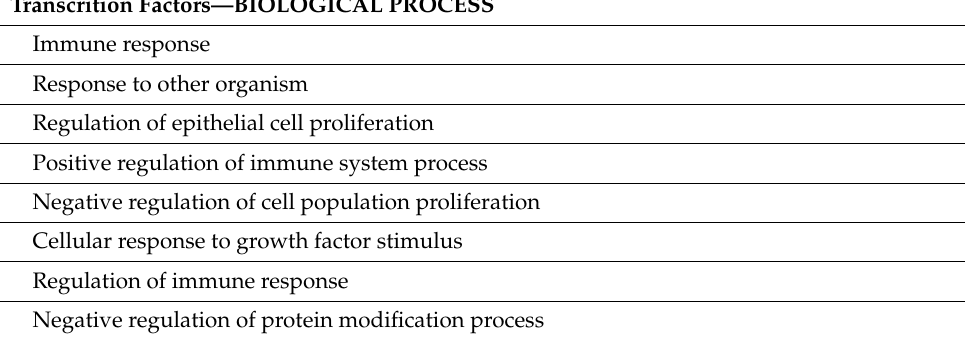
Table 1. Biological processes overrepresentation of the 80 potential NAPRT transcription factors. Only child terms relative to 10 or more genes and with a fold enrichment of over 3 are presented, by decreasing fold-enrichment order. Complete results are listed in Supplementary Table S4.